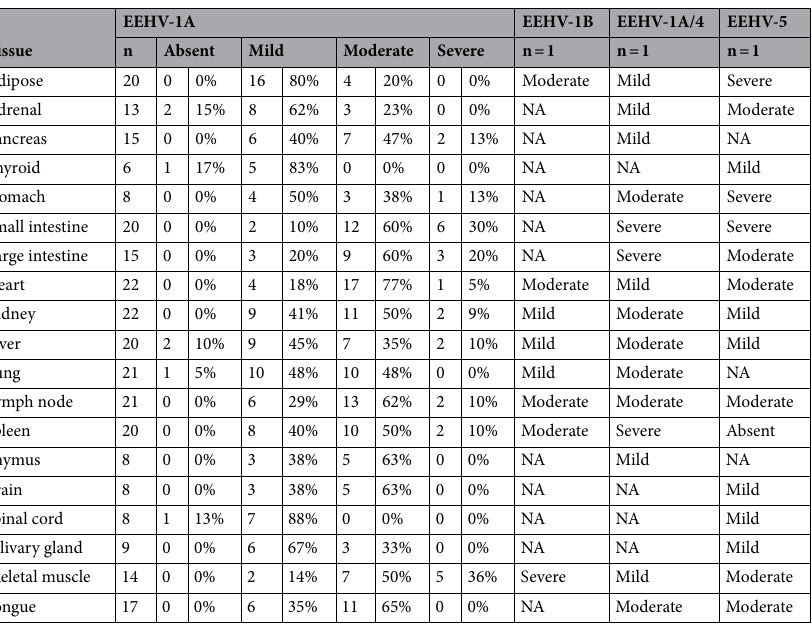
Table 2. Oedema scores in organs from Asian elephant endotheliotropic herpesvirus-haemorrhagic disease fatalities in Europe. NA; tissue not available.